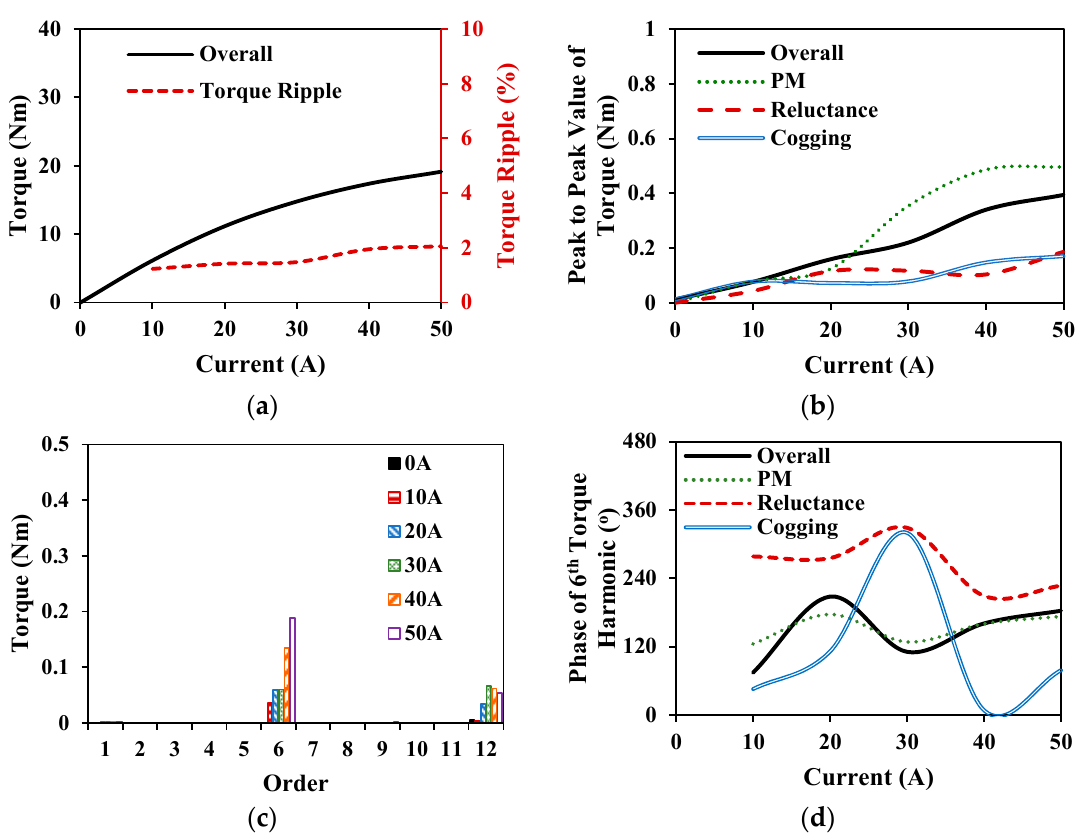
Figure 33. Torque characteristics of 12s8p-PSCPPM machine. ( a ) Average torque and torque ripple. ( b ) Peak to peak value of torque components. ( c ) Overall torque ripple spectra. ( d ) Phases of domi- nant 3rd order torque harmonics.